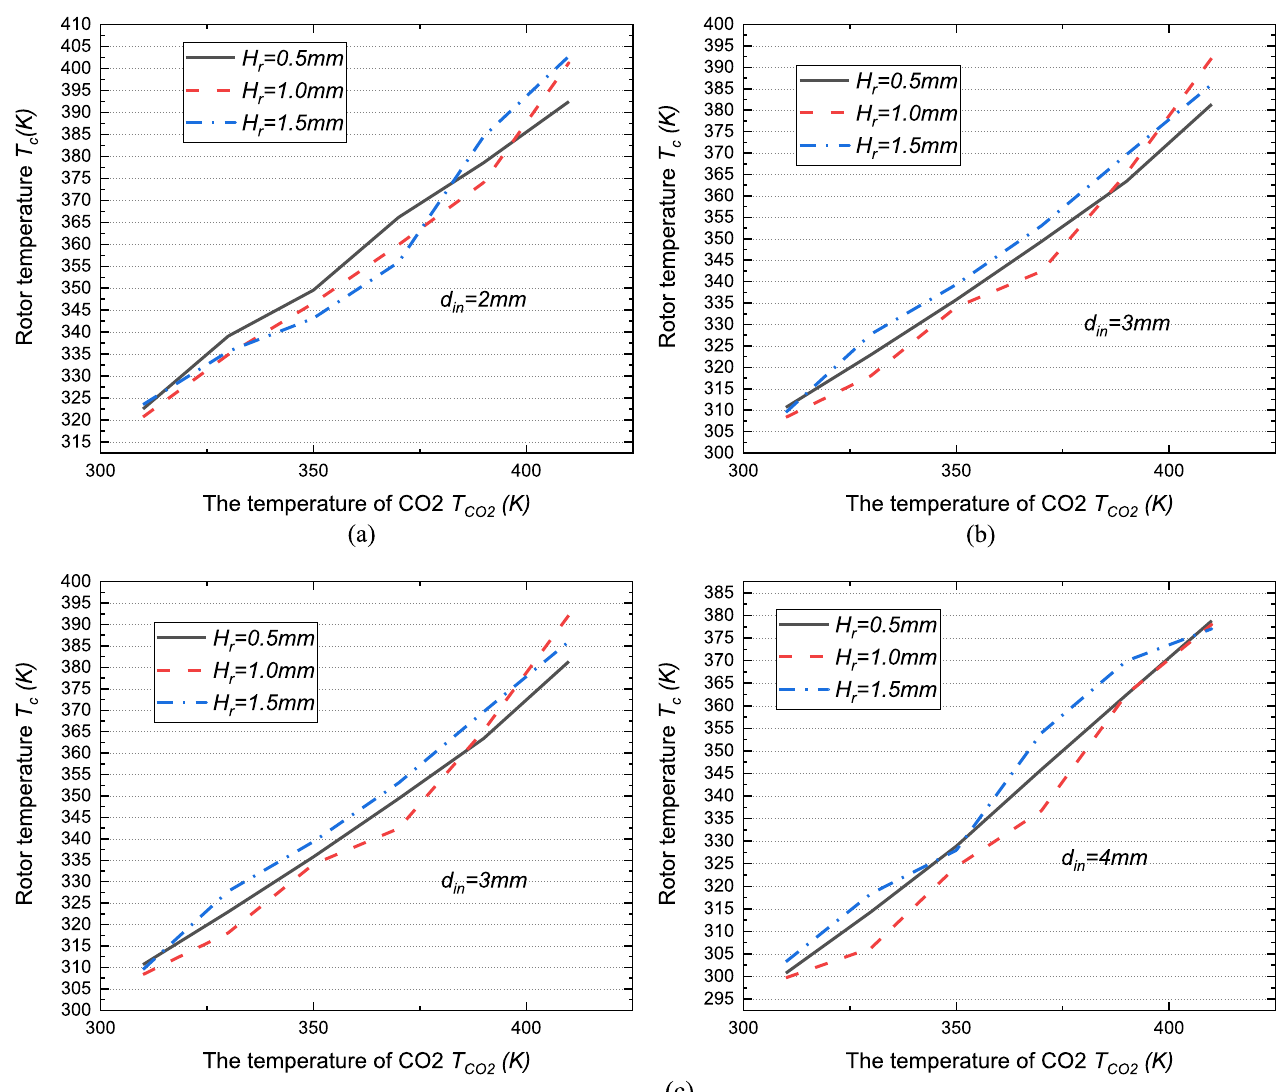
Fig. 11. The temperature of SCO2 versus free end temperature, calculation condition: (a) d in =2 mm, (b) d in =3 mm, (c) d in =4